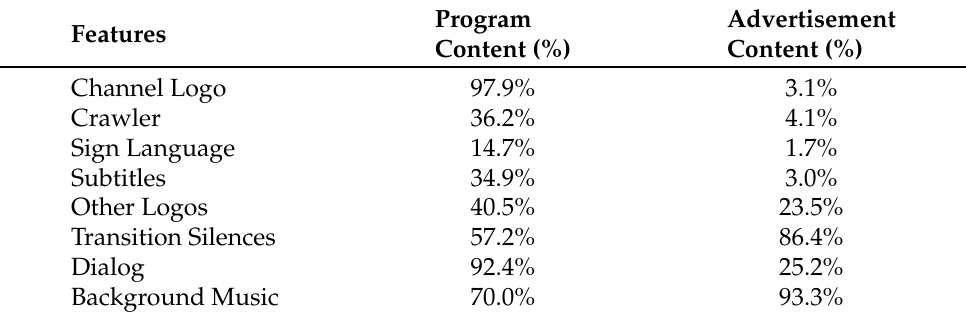
Table 2. Temporal distribution of the presence of the visual features.